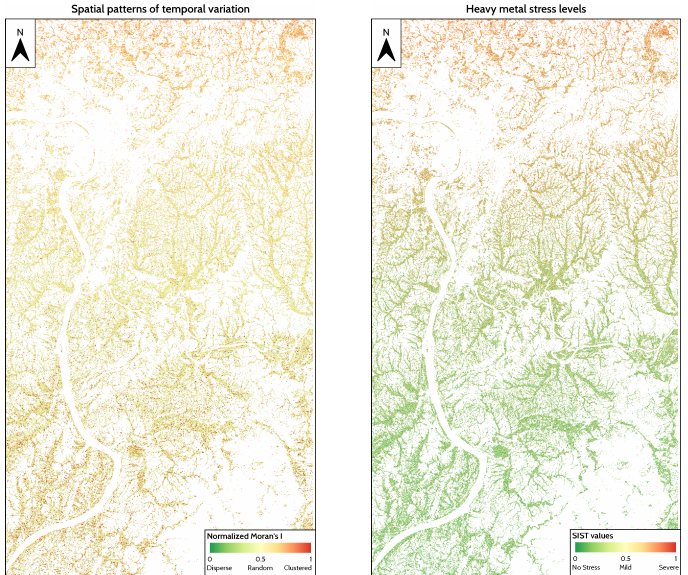
Figure 9. Spatial distribution of Moran’s I of temporal stability and stress index based on spatial and temporal characteristics (SIST). ( Left ): Normalized Moran’s I of temporal stability, ranging from 0 to 1. Values close to 1 indicate that the pixel tends to be clustered, 0.5 indicates perfect randomness, and 0 indicates complete dispersion. ( Right ): Spatial distribution of normalized SIST ranging from 0 to 1. A lower value of SIST (greener) indicates the rice pixel is less likely to be under heavy metal